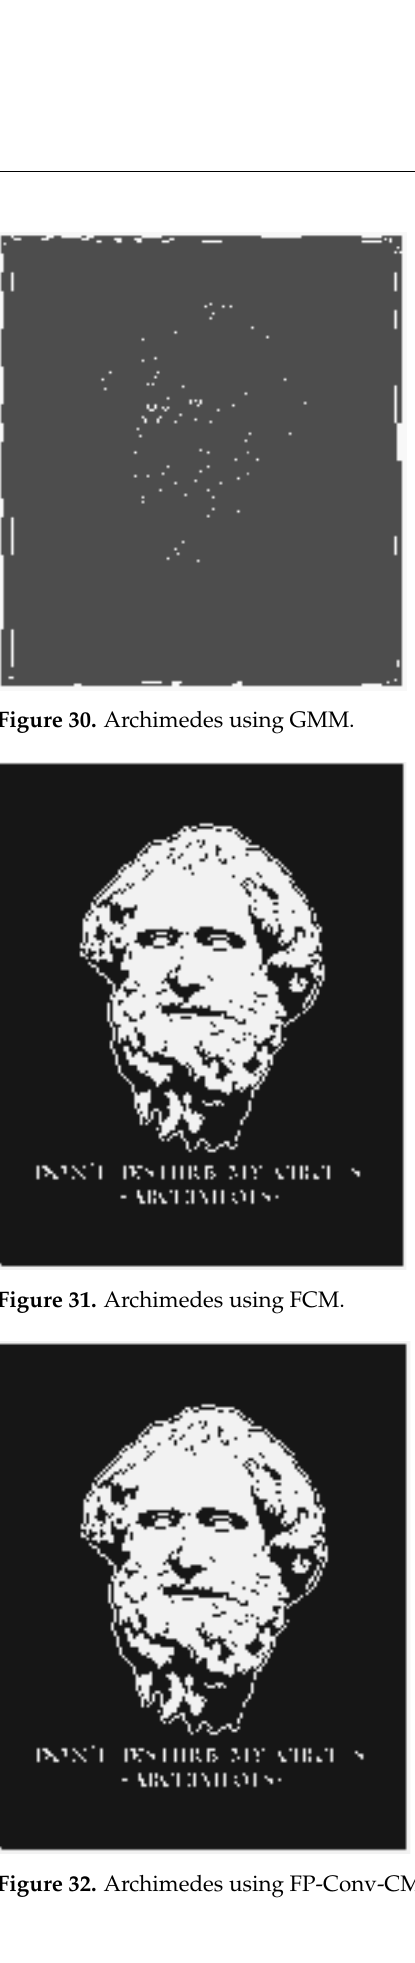
Figure 29. Cameraman using FP-Conv-CM.